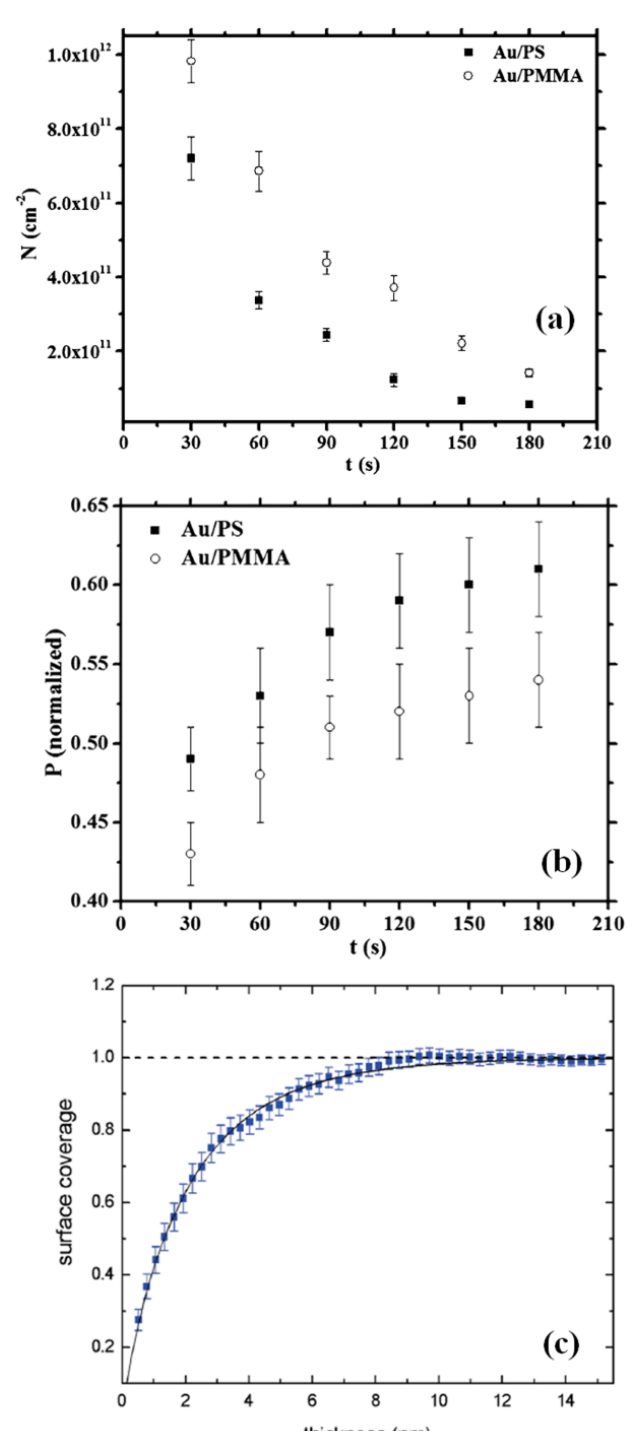
Figure 6. Evolution of the Au islands surface density N ( a ) and surface coverage ( b ) as a function of the deposition time for 30 ≤ t ≤ 180 s, on polystyrene (squares) and on poly(methyl methacrylate) (circles). ( c ) Surface coverage evolution for Au NPs deposited on poly(N-vinylcarbazole) as a function of the deposited film thickness. ((a,b): reproduced with permission from [21], Copyright Springer 2011; (c): reproduced with permission from [13], Copyright American Chemical Society